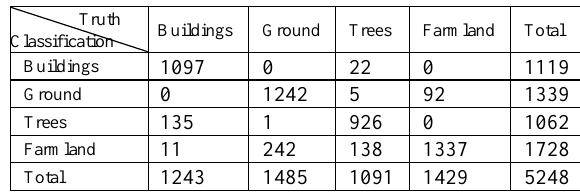
Table 2. Confusion matrix of the classification results based